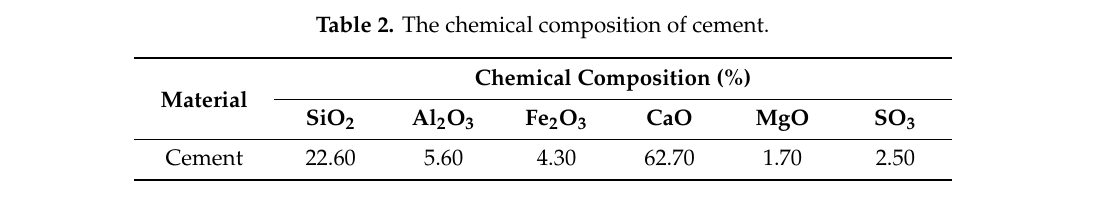
Table 3. The performance indicator of basalt fibers.